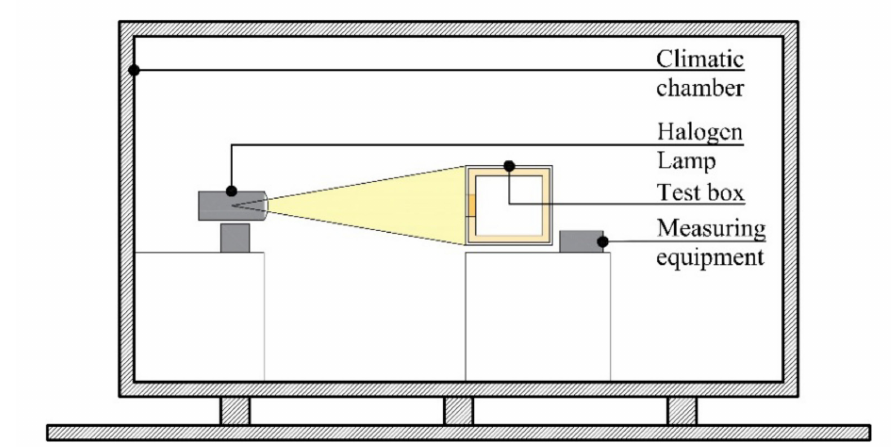
Figure 6. The experimental setup in the climate chamber